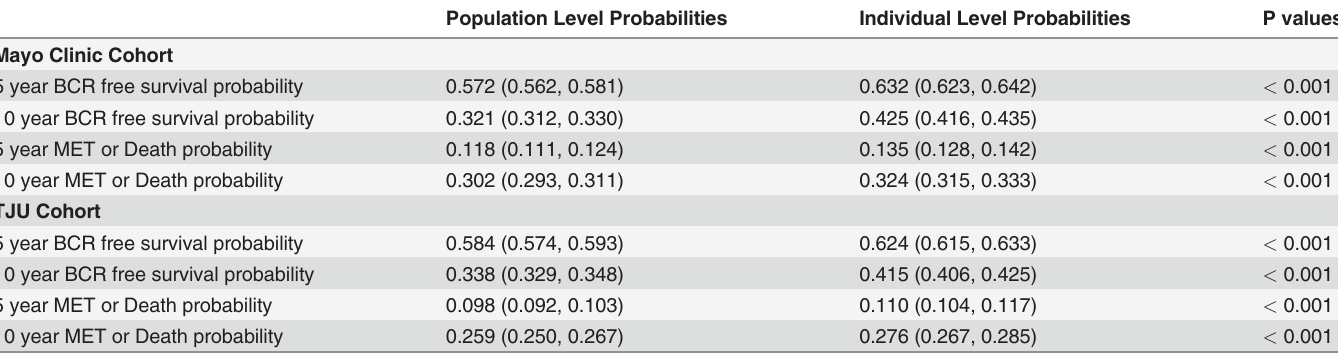
Table 2. Comparison of 5 and 10 year outcomes for population level probabilities vs. individual level probabilities using usual care treatment. Population Level Probabilities